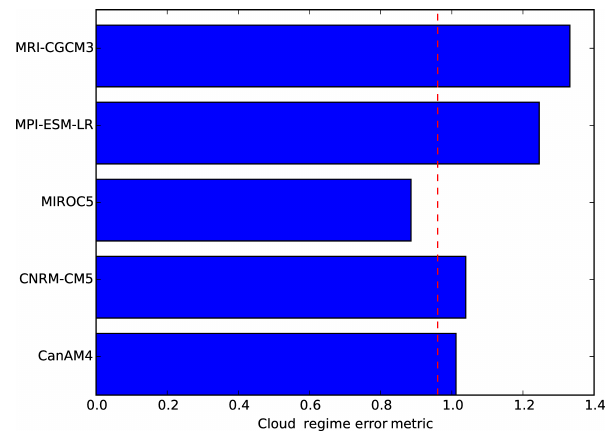
Figure 13. Cloud Regime Error Metric (CREM) from Williams and Webb (2009) applied to some CMIP5 AMIP simulations with the required data in the archive. The results show that MIROC5 is the best performing model on this metric, other models are slightly worse on this metric. The red dashed line shows the observational uncertainty estimated from applying this metric to independent data from MODIS. An advantage of the metric is that its components can be decomposed to investigate the reasons for poor